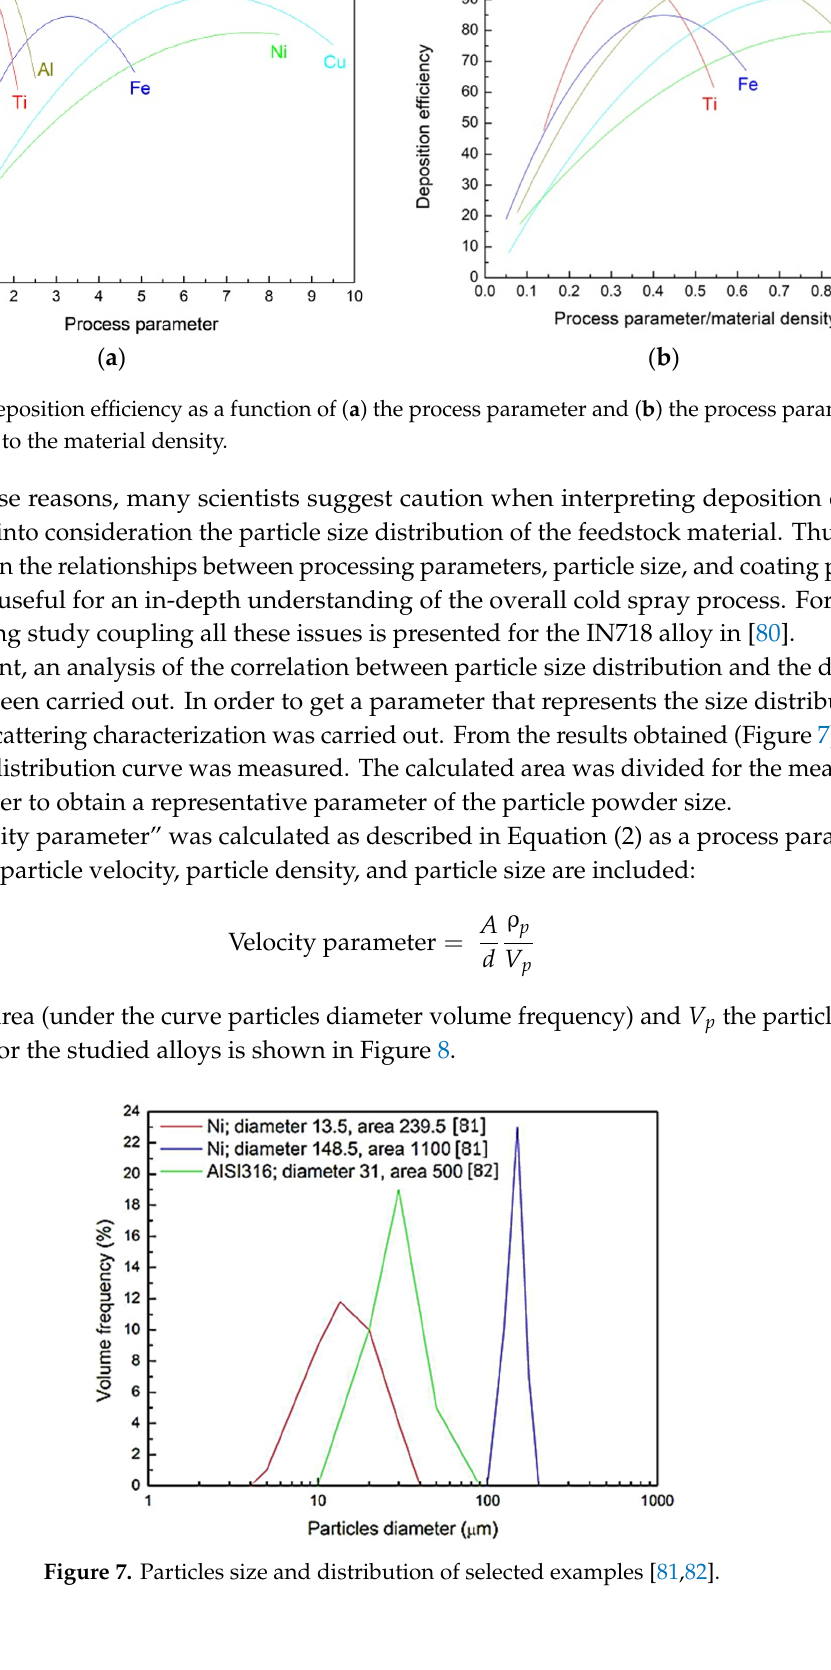
Figure 7. Particles size and distribution of selected examples [81,82].